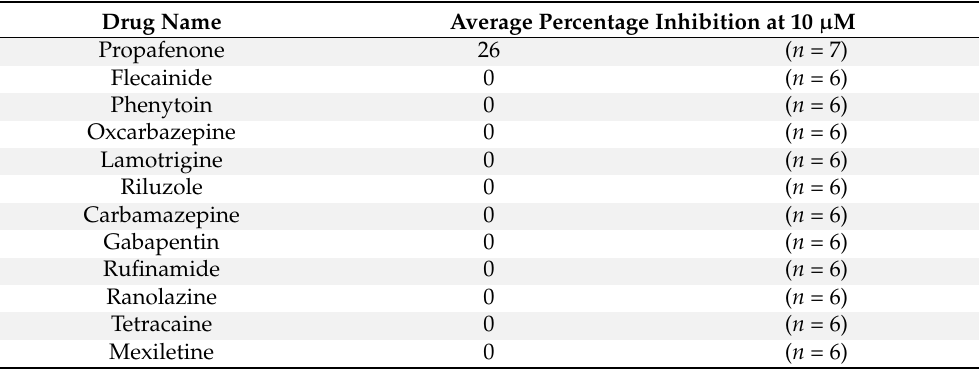
Table 1. TRPM8 percent inhibition data.